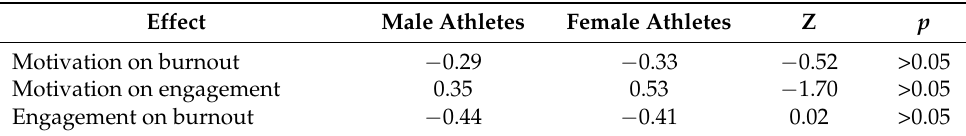
Table 3. Comparison of effects between male and female athletes.